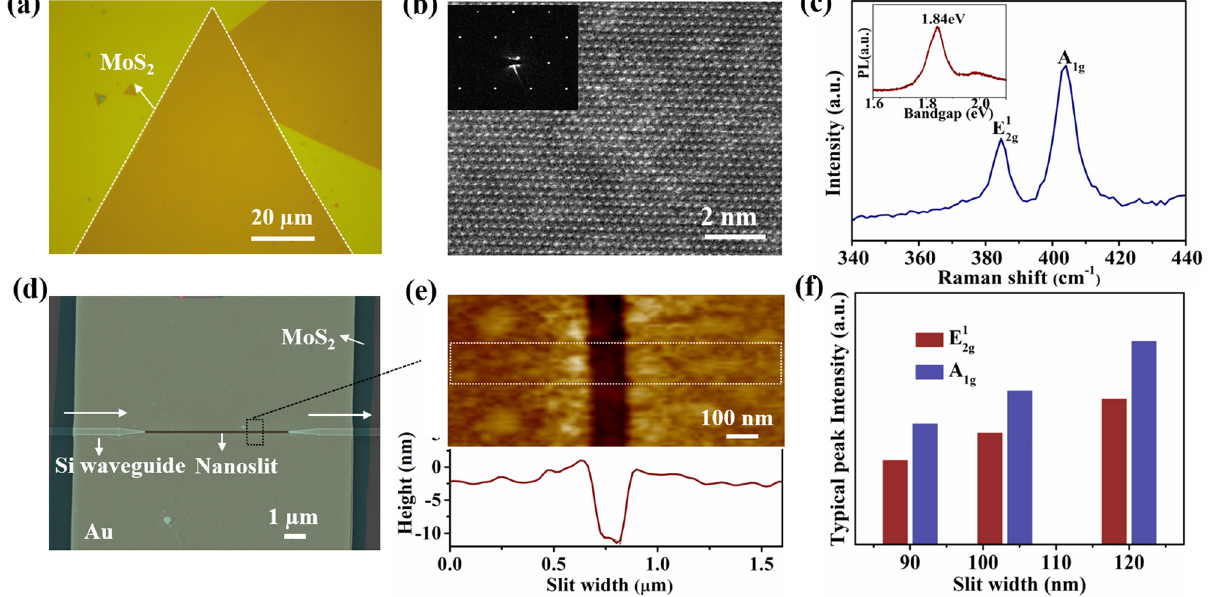
Figure 2: MoS 2 material and MoS 2 -plasmonic nanoslit device characterization. (a) Microscopy image of MoS 2 thin fi lm grown on SiO 2 . (b) STEM image of MoS 2 crystal; the inset shows the SAED pattern. (c) Raman and